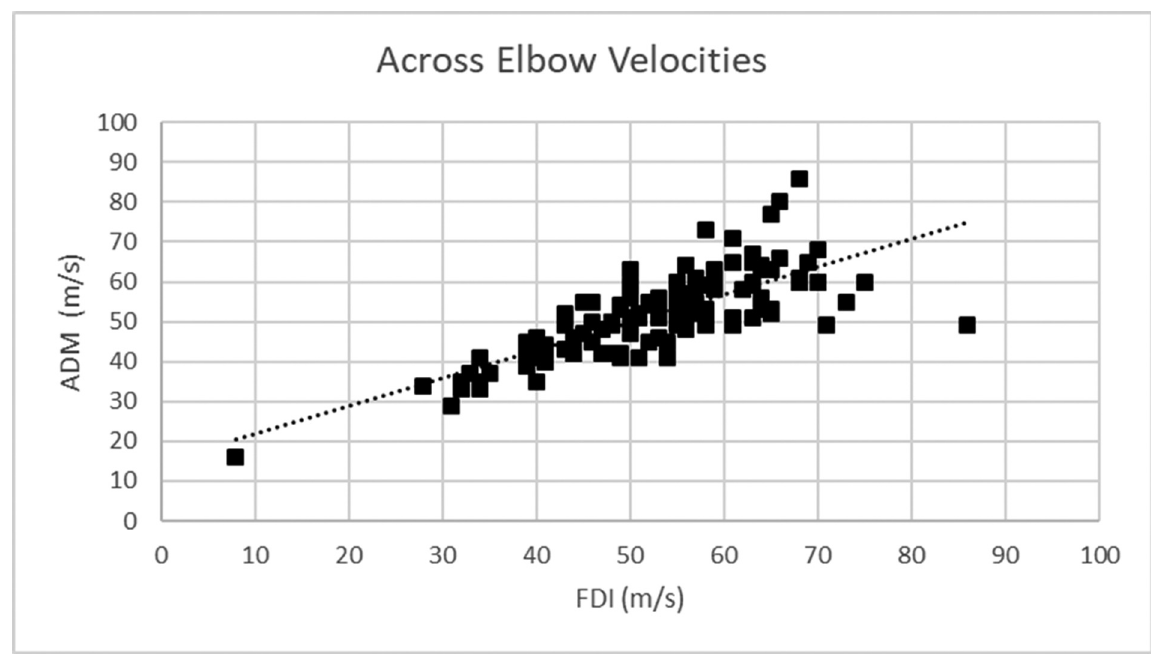
Fig. 2 Correlation between ADM and FDI NCV. ADM, abductor digiti minimi; FDI, fi rst dorsal interosseus; NCV, nerve conduction velocities.